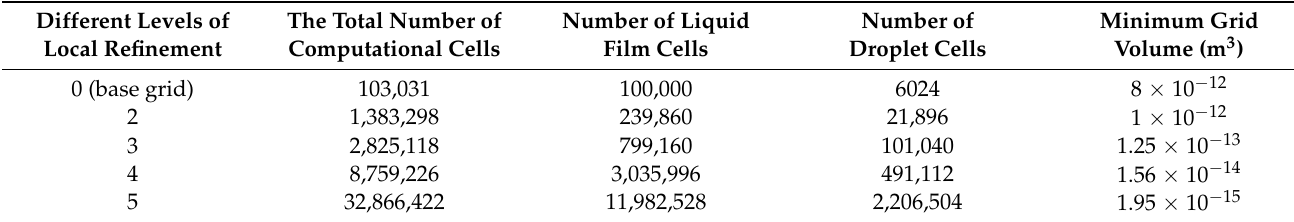
Table 1. Detailed grid parameters.